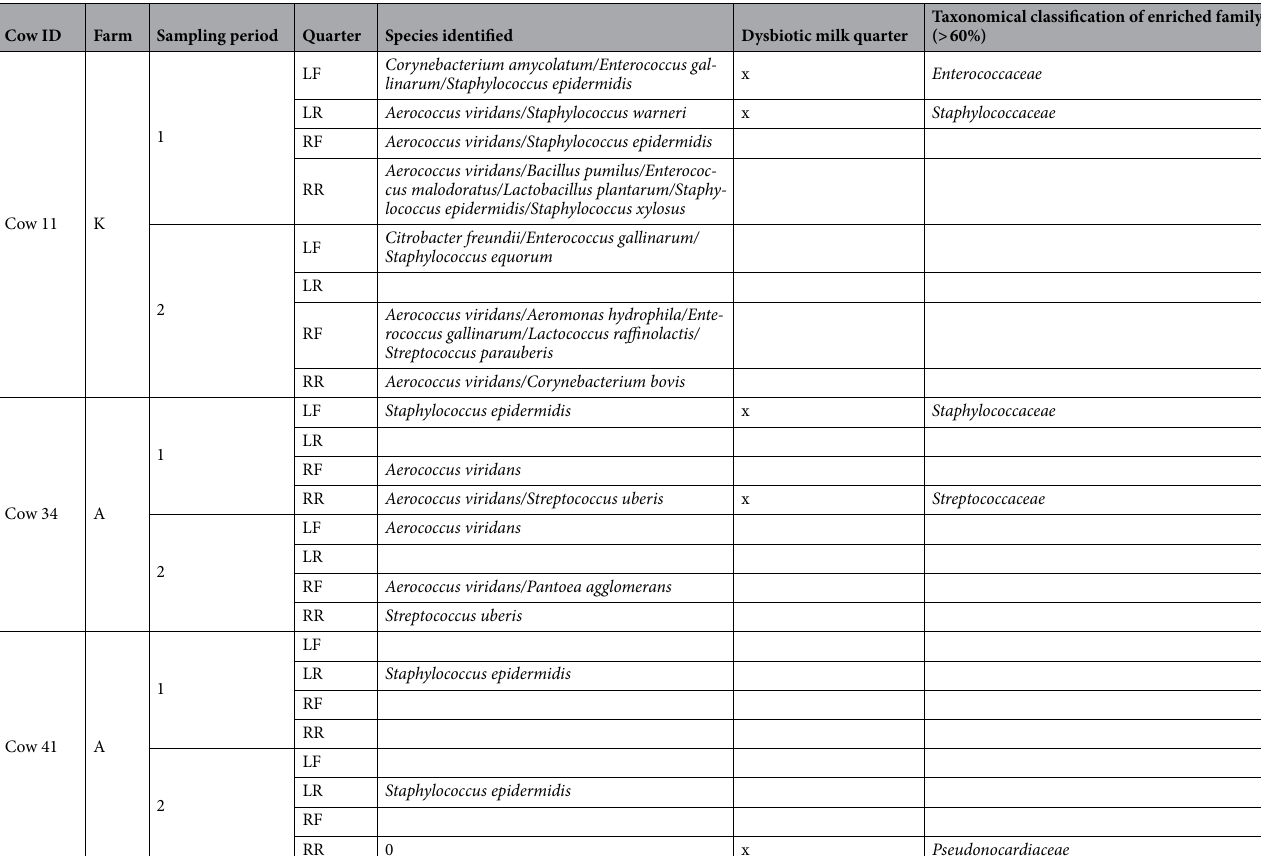
Table 2. Quarter milk samples with identified dysbiotic microbiota for 3 selected cows (11, 34, 41) and results from the maldi-TOF identification of the isolates for the same milk samples. The microbiota composition of these selected cows is presented in Fig.